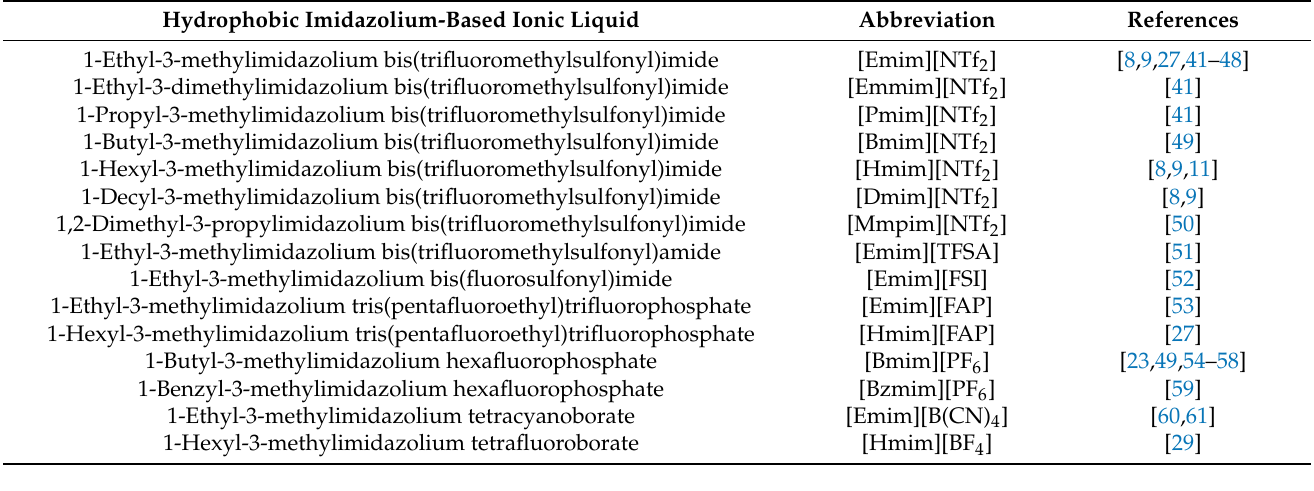
Figure 3. Chemical structures of hydrophilic imidazolium-based ionic liquids and the abbreviations are explained in Table 1. Table 2. Examples of hydrophobic imidazolium-based ionic liquids utilized for preparation of PVDF and PVDF-HFP blends and composites.